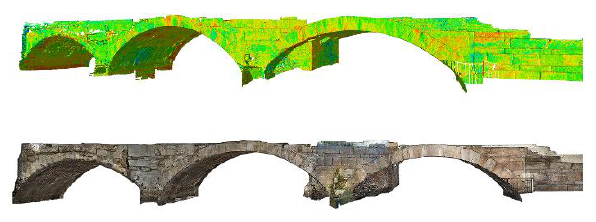
Figure 2. The point clouds of the bridge generated by laser scanning (above) and by SfM (below).